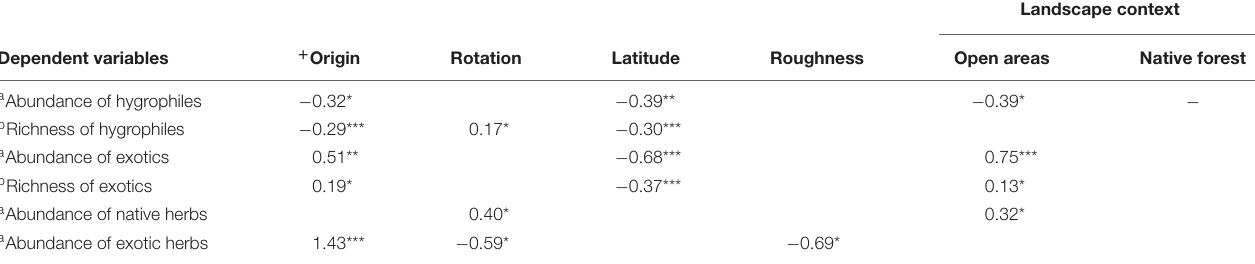
TABLE 1 | Coefficients of the best generalized linear models for the abundance and richness of plants in pine plantations with different origin and number of rotations.